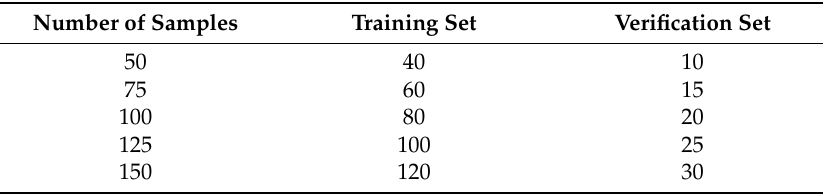
Table 4. Training set and verification set division.